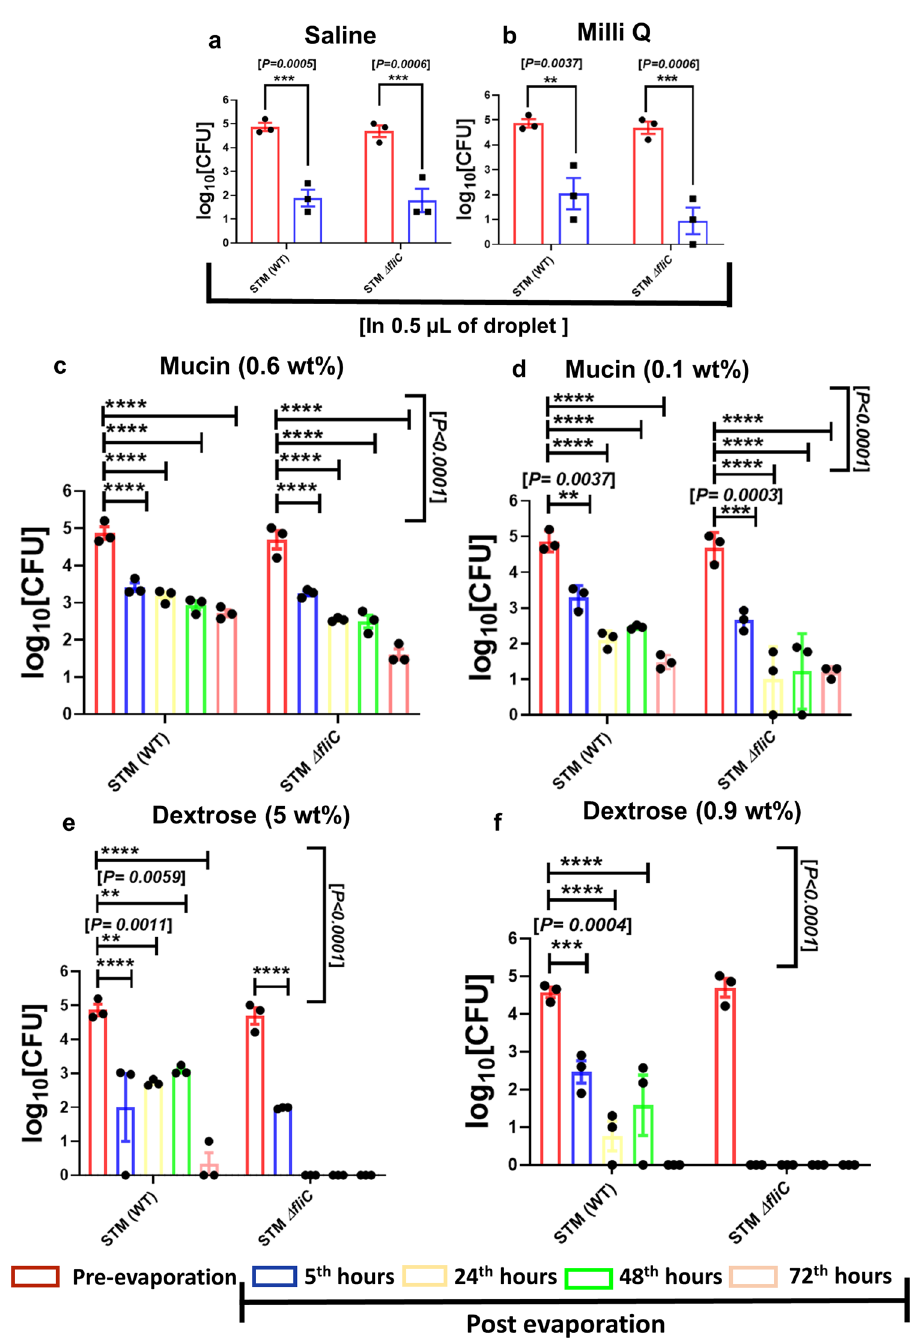
Fig. 8 The viability of wild type and fl iC de fi cient strains of Salmonella is signi fi cantly compromised post-evaporation (Supplementary Data 7). The assessment of in vitro viability of STM (WT) and Δ fl iC present in 0.5 μ L droplets of a saline (0.9% W/V), b milli-Q water before and 5 h after evaporation, ( N = 3, N = biological replicates, mean ± SEM). The time dependent viability of STM (WT) and Δ fl iC present in 0.5 μ L droplets of high and low concentration of c mucin (0.6 wt% for high concentration) and d mucin (0.1 wt% for low concentration) and e dextrose (5 wt% for high concentration) and f dextrose (0.9 wt% for low concentrations) solutions before and 5 h, 24 h, 48 h, and 72 h post evaporation, ( N = 3, biological replicates, mean ± SEM). In every independently done experiment a single bacterial culture (either wild type or fl iC mutant) was used to prepare a common pre-evaporating sample, which was followed by drop casting of the bacteria in saline, milli-Q, mucin, and dextrose solutions. ( P )* < 0.05, ( P )** < 0.005, ( P )*** < 0.0005, ( P ) **** < 0.0001, ns = non-signi fi cant, (2way